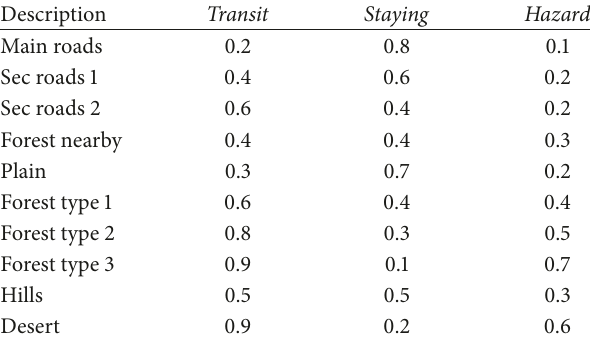
Table 3: Terrain input values.